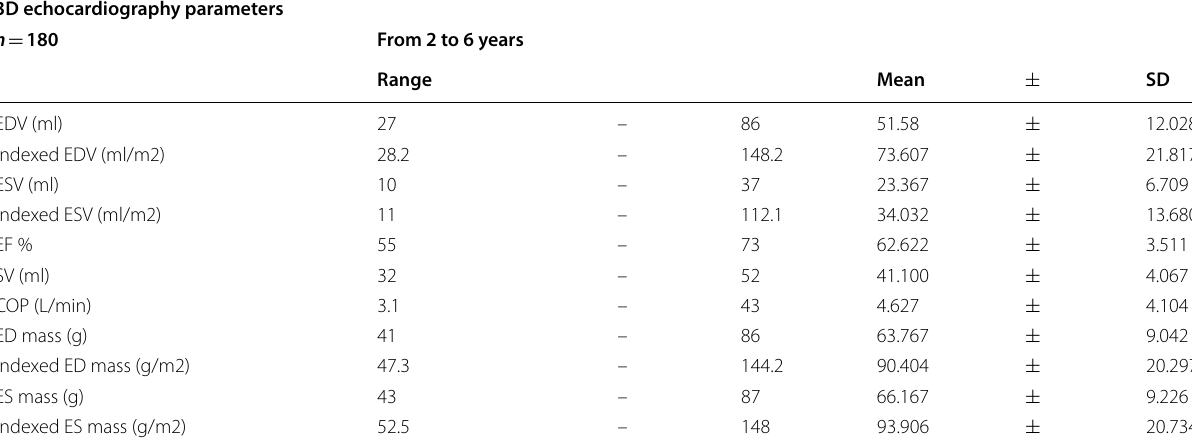
Table 3 Our study population 3D echocardiographic